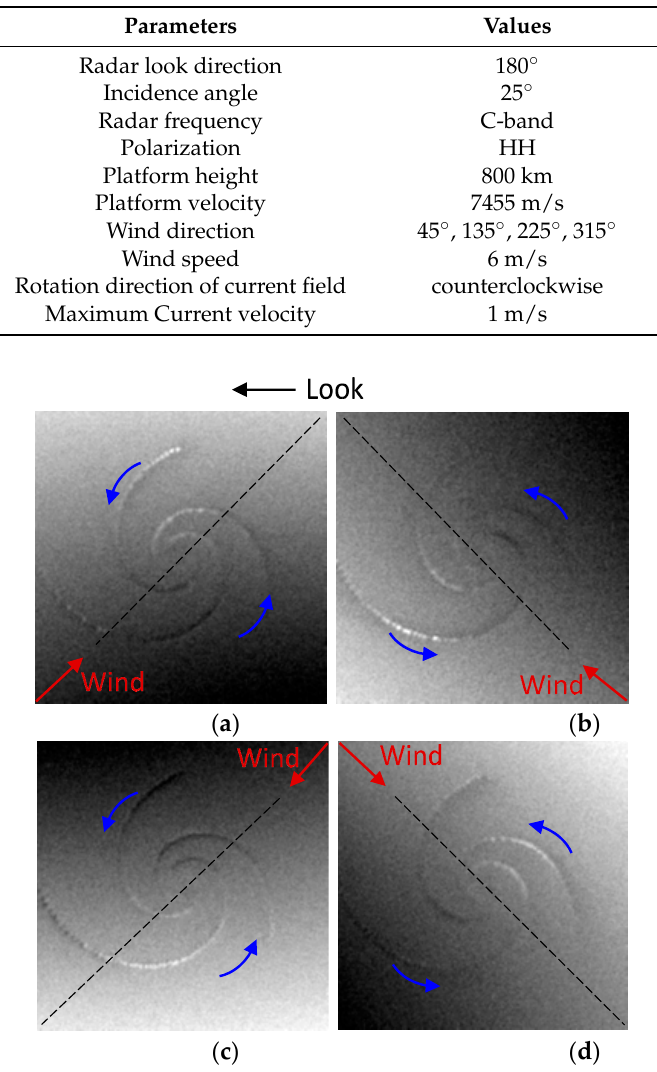
Figure 14. Simulated SAR images under different wind directions. ( a – d ) correspond to the wind directions of 45°, 135°, 225°, and 315° respectively. The black arrow represents the radar look direction and the blue arrow indicates the rotation direction of the current field.